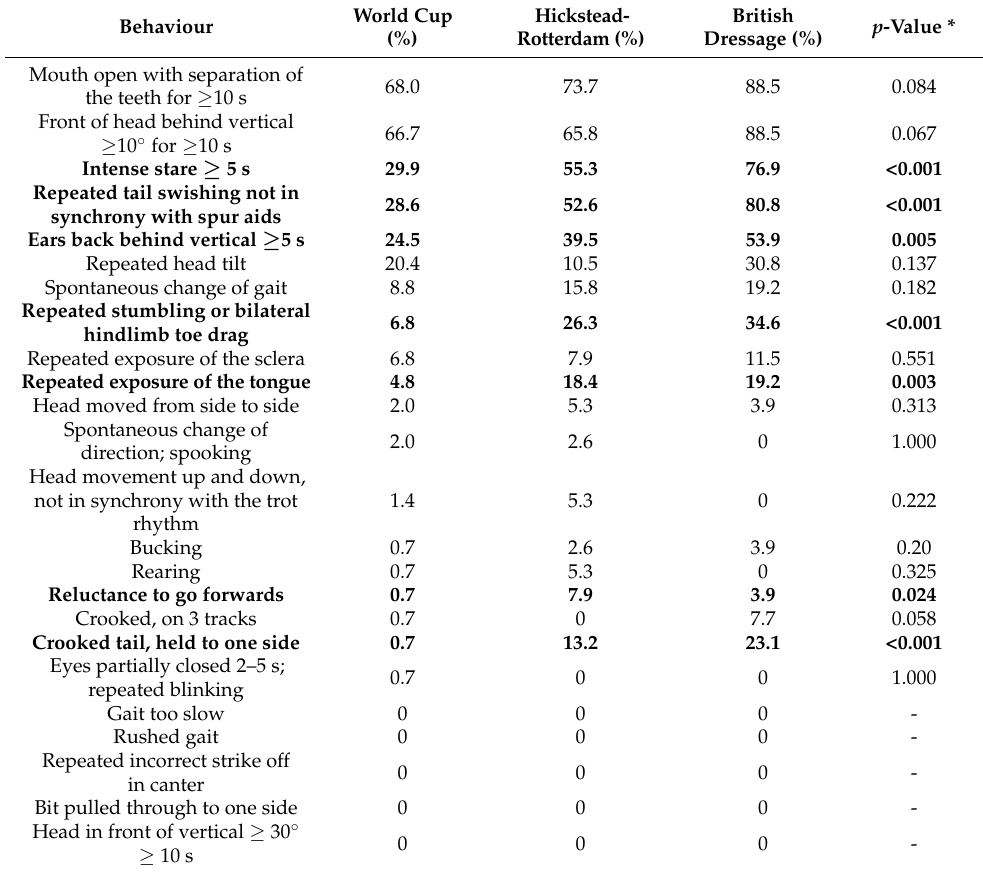
Table 6. Summary of the frequency of occurrence (percentage) for each of the behaviours ( n = 24) of the Ridden Horse Pain Ethogram for all venues combined for competitors ( n = 147) at the World Cup Grand Prix Dressage Western League qualifying competitions ( n = 7) and the finals ( n = 2) [10], the Hickstead-Rotterdam Grand Prix Challenge ( n = 38) and the British Dressage Grand Prix National Championship ( n = 26). Significant differences are highlighted in